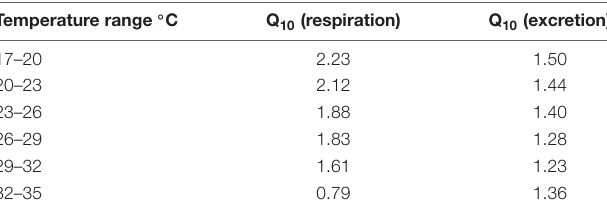
TABLE 1 | Q 10 values for respiration and excretion in Creseis acicula exposed to different temperatures. Temperature range ◦